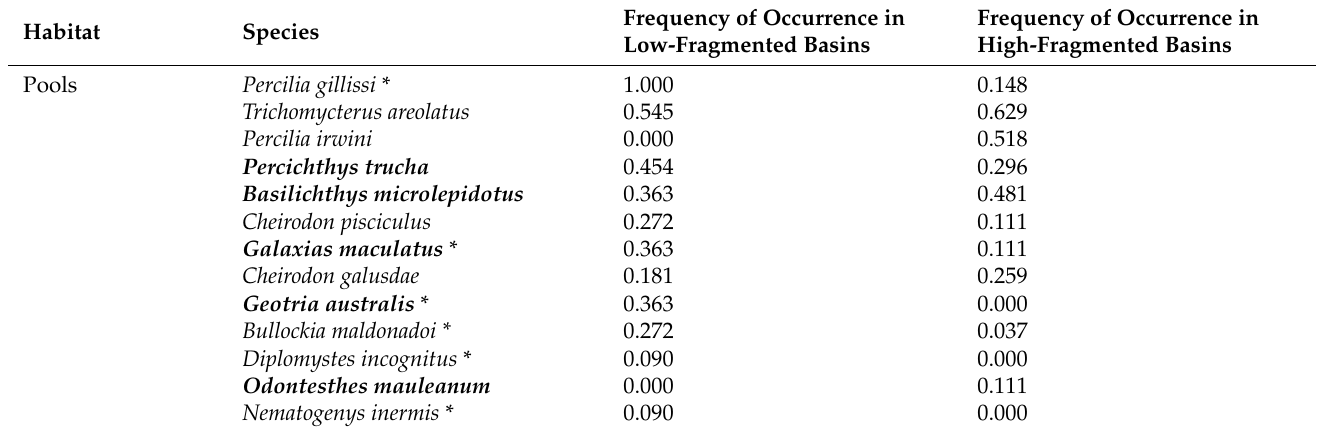
Table 2. Frequency of occurrences of native species present in the eight basins studied according to level of fragmentation. High-dispersal capacity species appear in bold, while species with significant differences in occurrences are indicated with an asterisk (*).